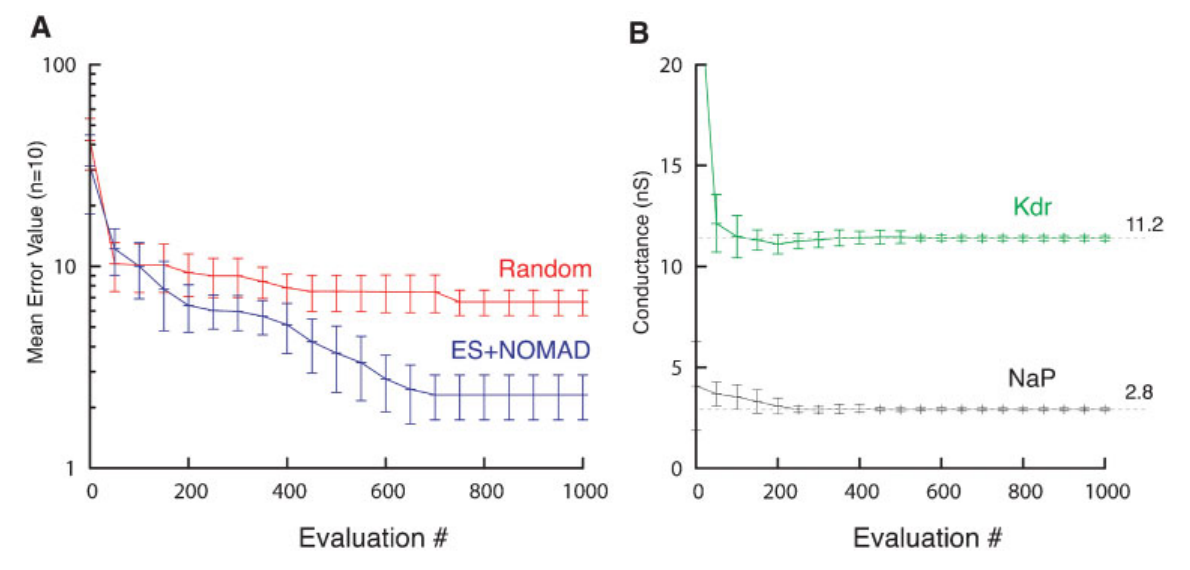
Figure 12. ES/NOMAD evolution of pacemaker neuron model . ( A ) Evolution of best error value found by Random (red) and hybrid ES+NOMAD (blue) searches. The data points (mean ± sdv) are averaged over 10 different runs of the algorithms using different random seeds. After 500 error evaluations Neurofitter switched from ES to NOMAD. ( B ) The evolution of the best maximal NaP and Kdr channel conductances during the same 10 runs as in A for the hybrid ES+NOMAD algorithm. The dashed line shows the maximal conductance of the target data. Not the entire range of the y-axis is shown to allow a better scaling of the plot.